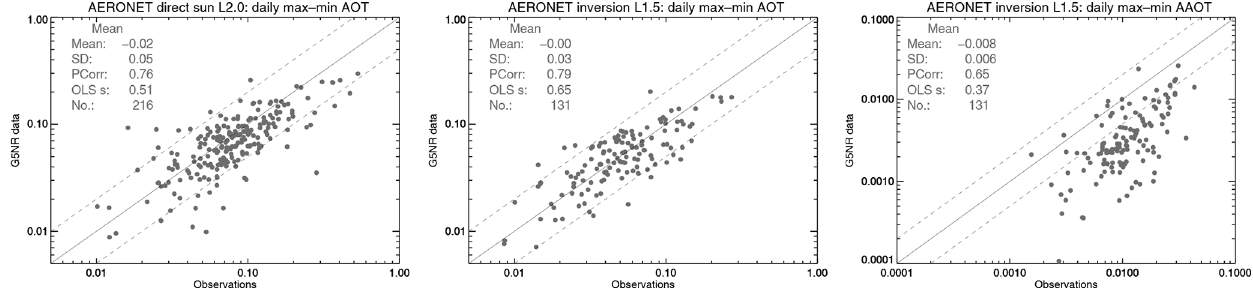
Figure 2. Evaluation of the G5NR simulation of AOT and AAOT with AERONET data. Each dot represents the yearly average of daily variation (maximum minus minimum value) for a single AERONET site (with at least 100 observations in 2006). The grey text summarizes the statistics over all data points in the figure. In all figures, hourly G5NR model data were collocated in time and space with AERONET observations before calculating site